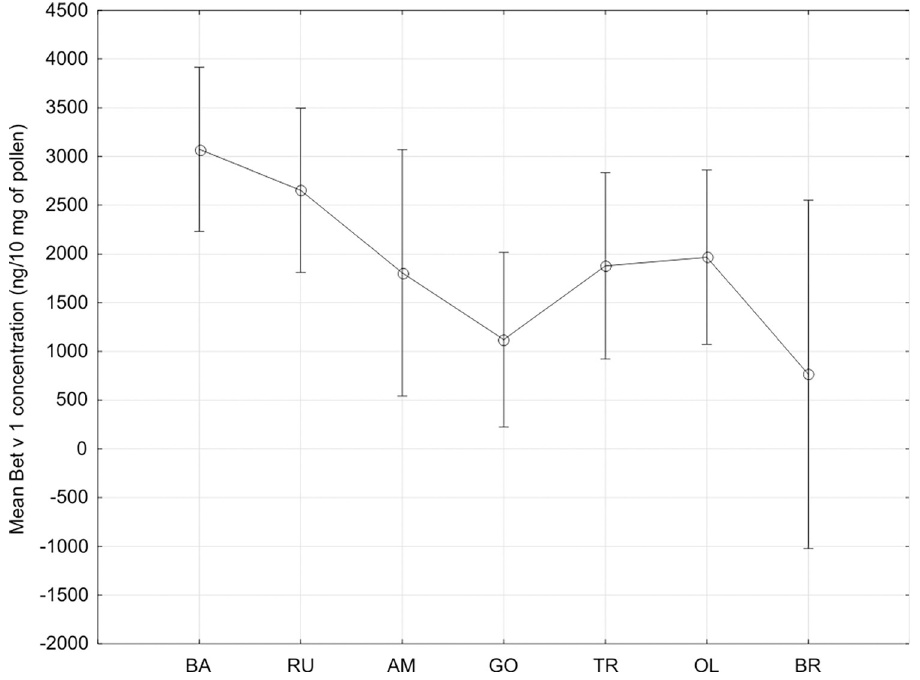
Fig 3. Mean Bet v1 concentration in the particular study sites. RU–Ruczaj, BA–Batowice, AM–al. Mickiewicza, OL– Olkusz, TR–Trzebinia, GO- Gorlice, BR—Brunary.